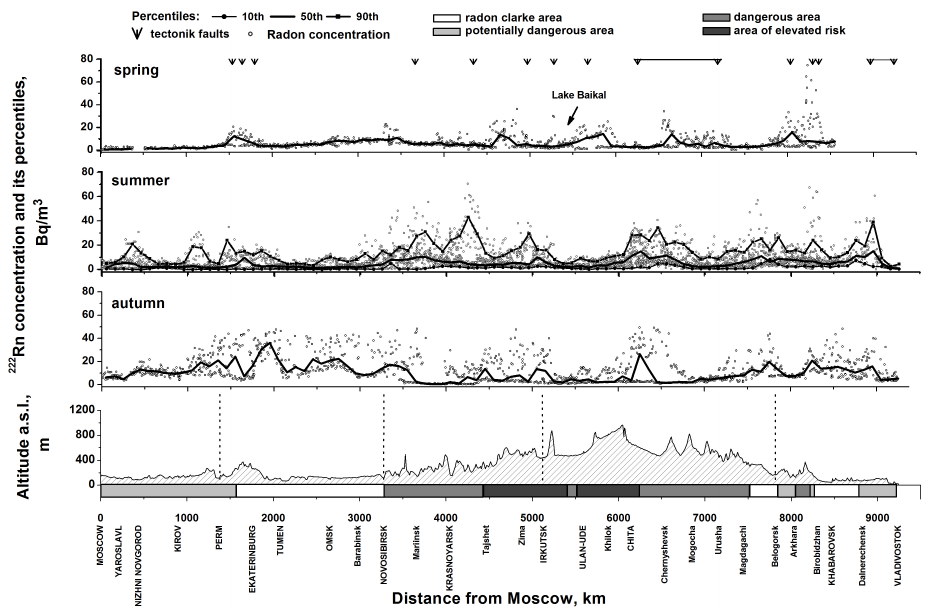
Fig. 2. Spatial distribution of surface 222 Rn concentration (10min average values) and altitude a.s.l. from Moscow to Vladivostok in TROICA expeditions. The radon risk areas corresponding to the map of radon risk of Russia are presented as shaded rectangles. Percentiles are presented for 10min radon values for each 100km route part (for spring and autumn data only the 50th percentile values are presented because of a limited data set for